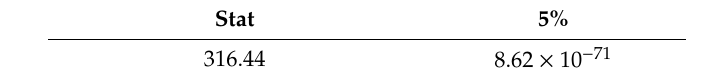
Table 6. The white noise test results of water consumption data difference at monitoring point 2.